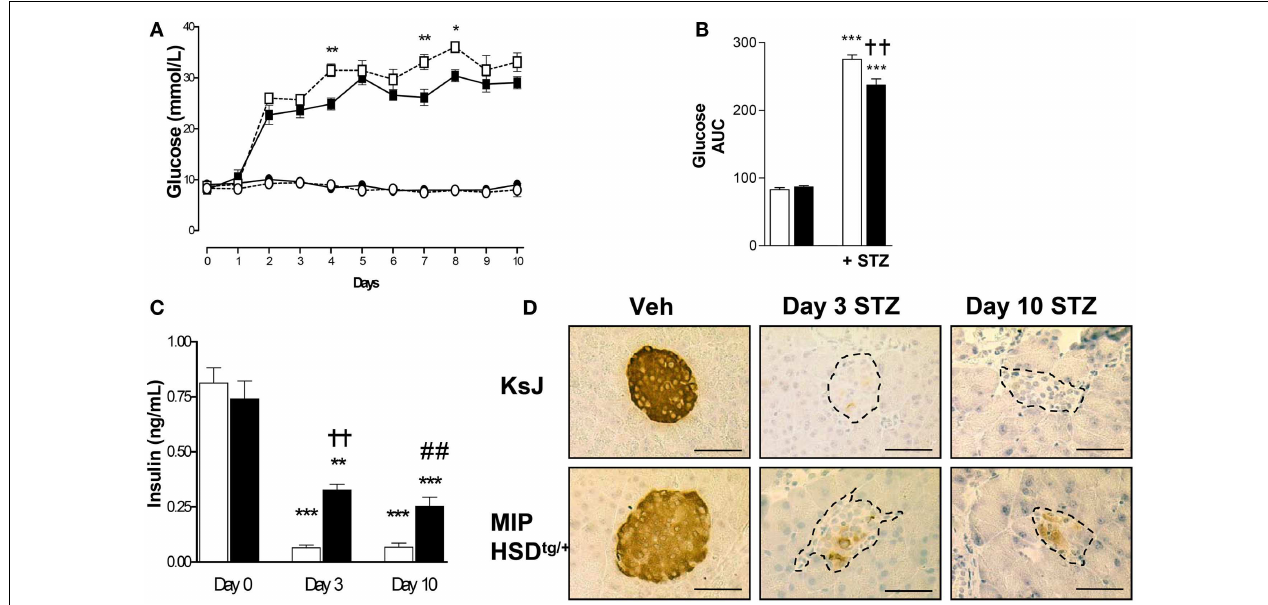
vs. vehicle, ** P < 0.01 for MIP-HSD1 tg/ + STZ vs . KsJ STZ. (C) Plasma insulin at day 0 (before injection) and days 3 and 10 post-STZ injection in littermate KsJ mice (white bars) and MIP-HSD1 tg/ + mice (black bars). ** P < 0.01 and *** P < 0.001 day 3 and 10 vs. day 0.The decrease in plasma insulin was less severe in transgenic mice, †† P < 0.01 for day 3 MIP-HSD1 tg/ + STZ vs. day 3 KsJ STZ; ## P < 0.01 for day 10 MIP-HSD1 tg/ + STZ vs. day 10 KsJ STZ. (D) Insulin expression shown by immunohistochemical staining of paraffin-fixed pancreata from KsJ littermate (upper row) and MIP-HSD1 tg/ + (lower row) mice after vehicle treatment (Veh, left lane) and 3 (middle lane) or 10days post-STZ treatment (right lane). Bars = 50 µ m magnification ×